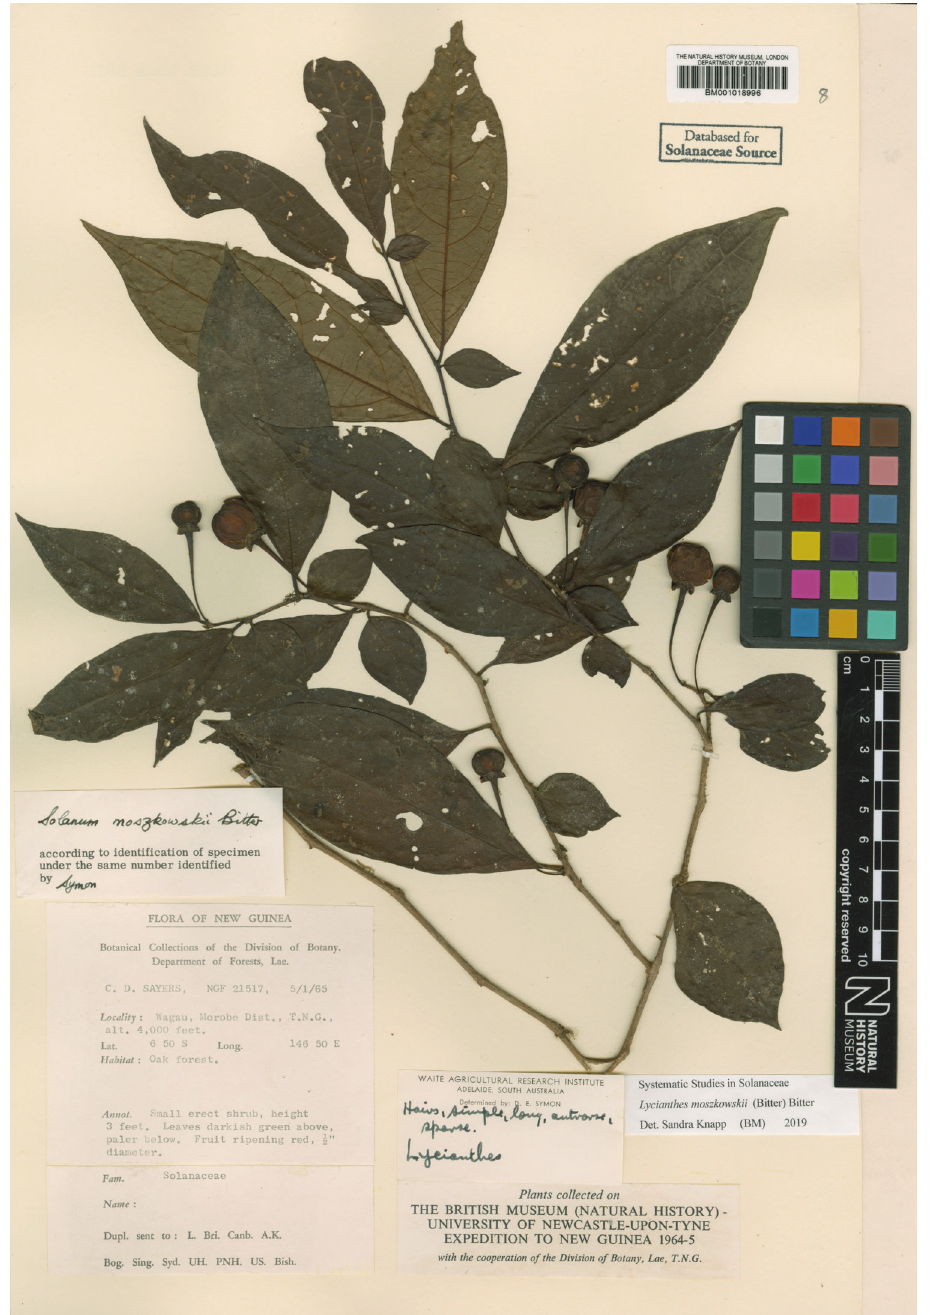
Figure 32. Lycianthes moszkowskii herbarium specimen. Papua New Guinea. Morobe: Sayers NGF- 21517 (BM001018996). Courtesy of the Trustees of the Natural History Museum, London, reproduced with